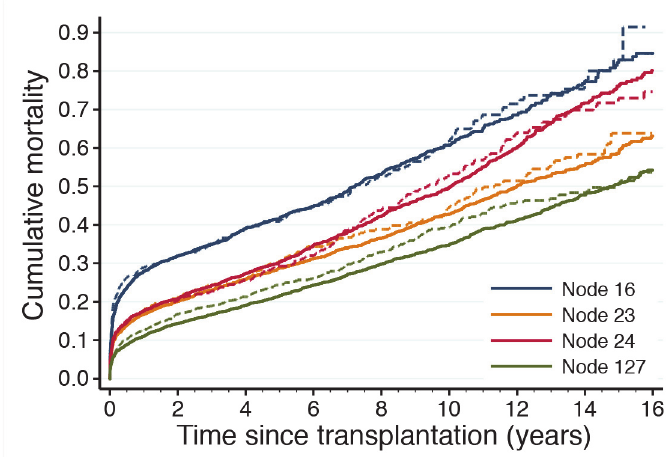
Fig 6. Validation of the IHTSA variable decision tree. This graph illustrates the difference in observed cumulative mortality for patients belonging to leaf nodes 16, 23, 24, and 127 in the decision tree. The line color corresponds to the leaf node color in Fig. 5. The solid lines show the observed cumulative mortality for transplanted patients in the derivation cohort and dashed lines show the observed cumulative mortality for transplanted patients in the internal validation cohort (estimated with Kaplan-Meier failure